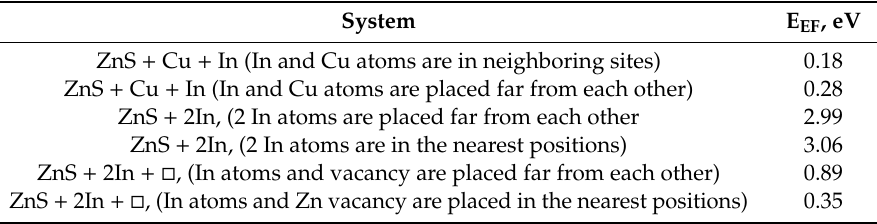
Table 1. Formation energy of sphalerite solid solutions (E EF ) derived by DFT